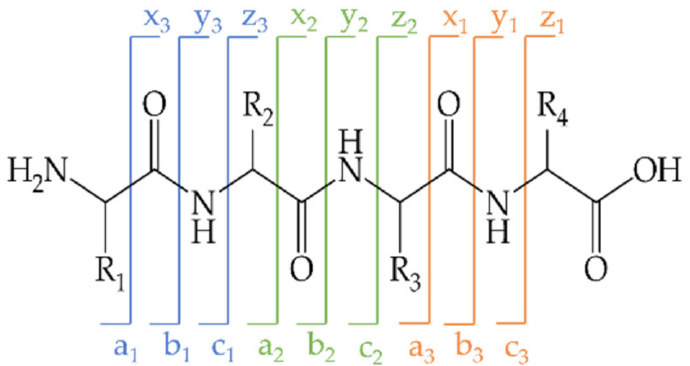
Figure 8. Designation of N - and C -terminal peptide fragments; redrawn from [62,63].